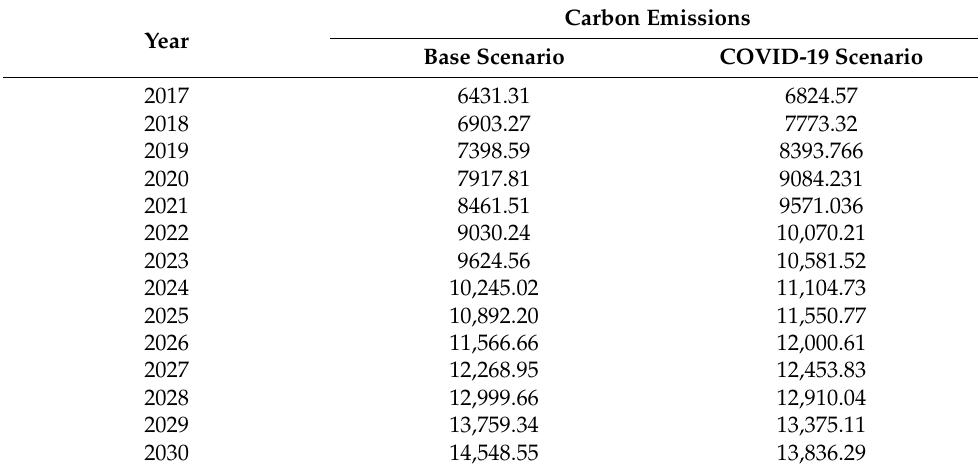
Table 5. Carbon emission prediction of Changsha.